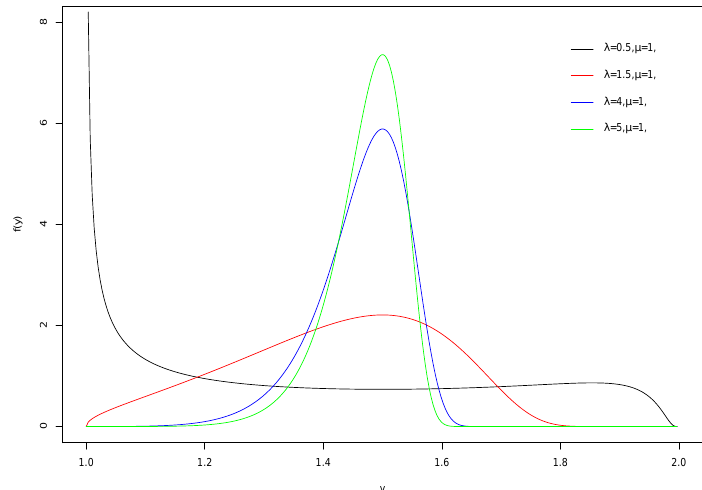
Figure 1. The pdfs of two parameter RK distribution for various parameter values.